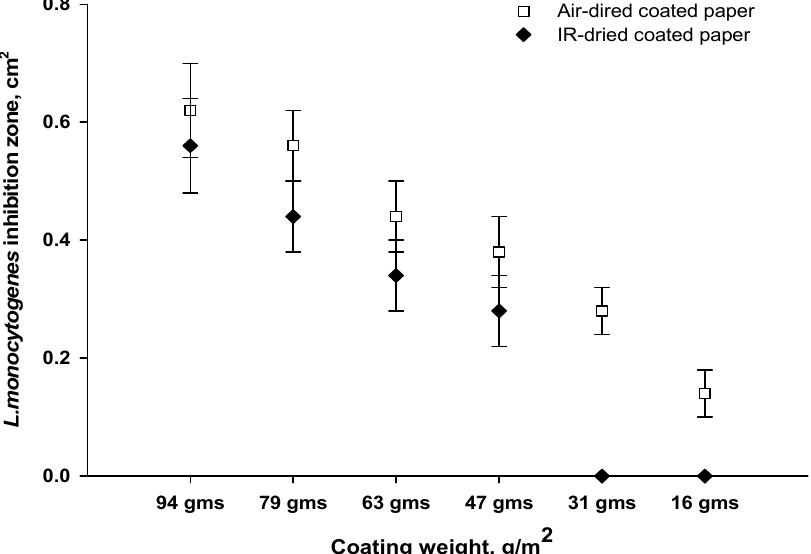
Figure 8. Effect of coating weight and drying on antimicrobial performance of bioactive papers.